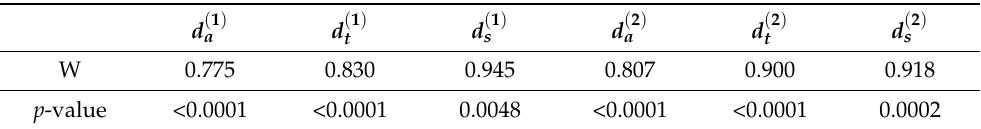
Table 6. Shapiro–Wilk test